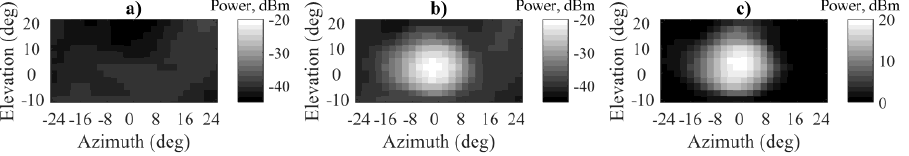
Fig. 8. Image of cube, the beam reflected from its surface falls directly into the receiving antenna: a) background image from radiolight lamps; b) the image of the cube in the radiolight c) differential